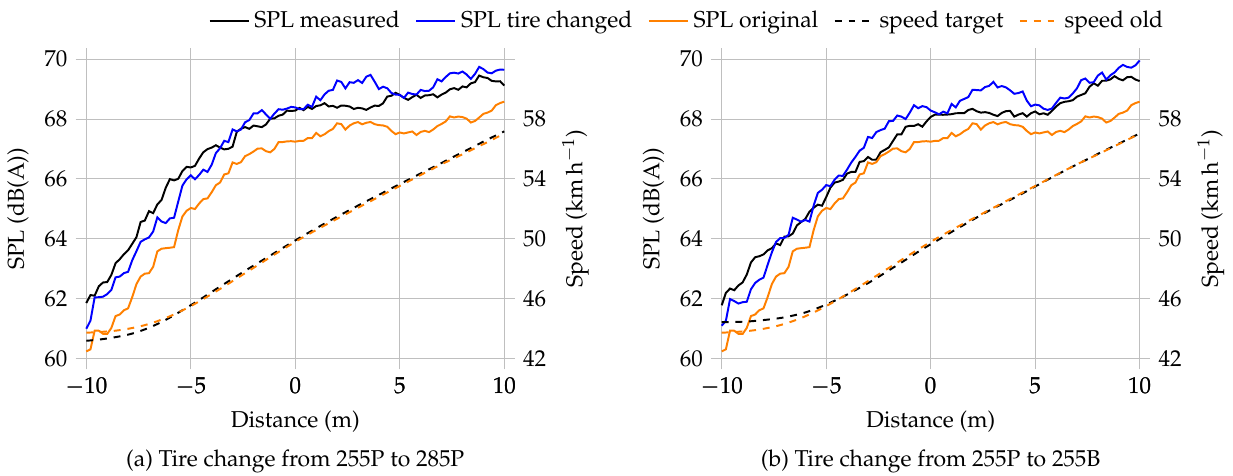
Figure 19. Tire change for LSHEV, tires measured while mounted on LSBEV, pred indicating the EV used for the prediction.